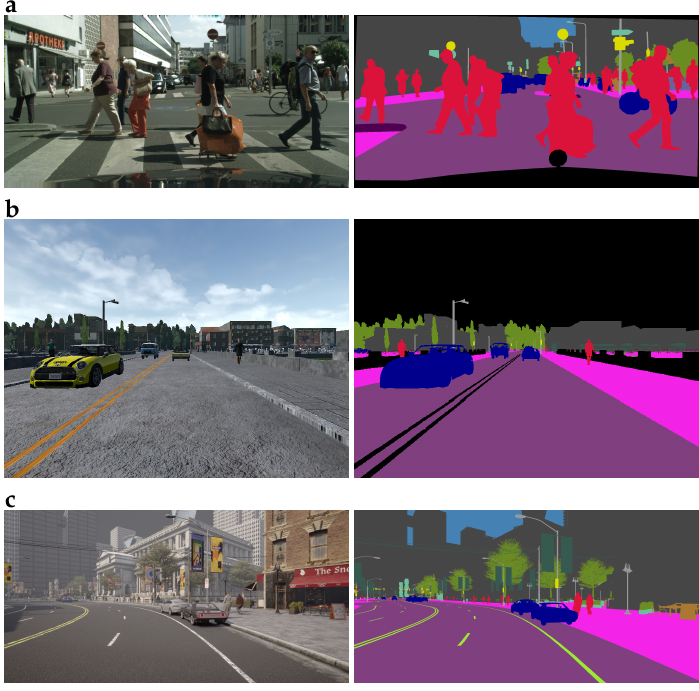
Figure 1. Sample images and their segmentation masks from the datasets: ( a ) Cityscapes dataset; ( b ) MICC-SRI (Media Integration and Communication Center–Semantic Road Inpainting) dataset; ( c ) CCM (Cityscapes-CARLA Mixed) dataset. Note that ( a , c ) are not to scale with respect to ( b ), as the actual resolution of ( a ) and ( a ) is 1024 × 2048 pixels vs. 600 × 800 pixels for ( b